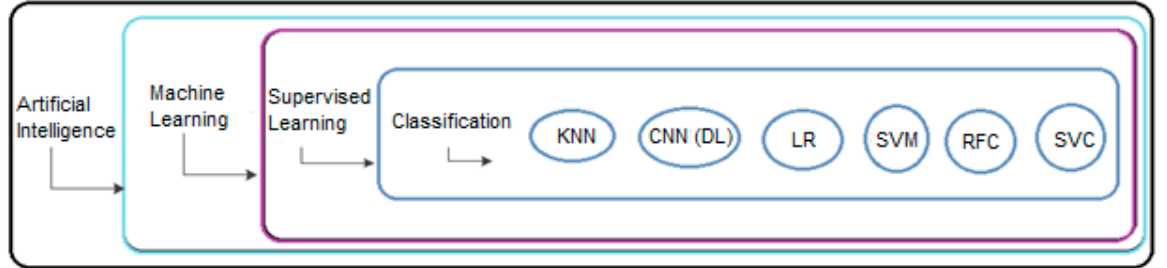
Figure 4. Hierarchy of machine learning techniques used in this work.